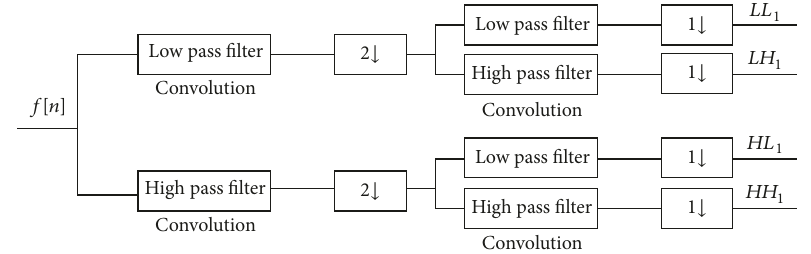
Figure 1: Extraction of 2D DWT